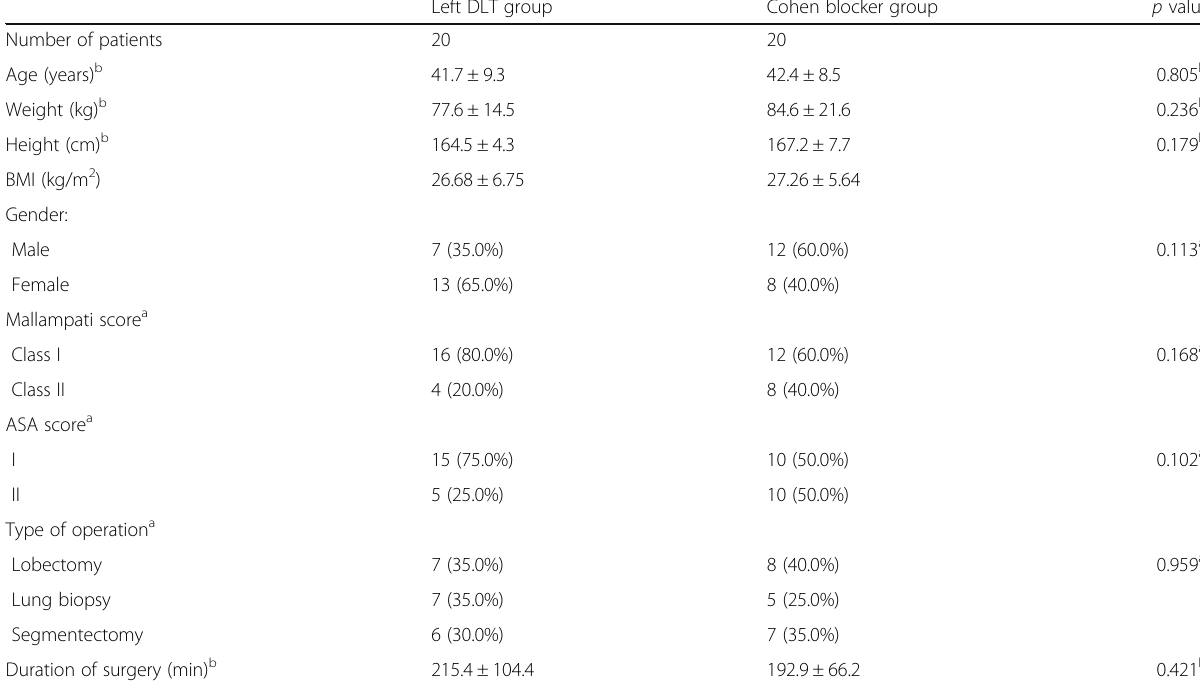
Table 1 Demographic and operative data